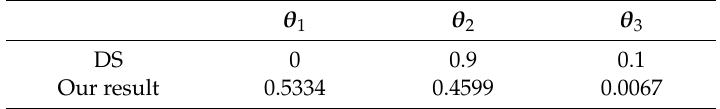
Table 2. Combination results of the modified evidence m 1 and evidence m 2 .